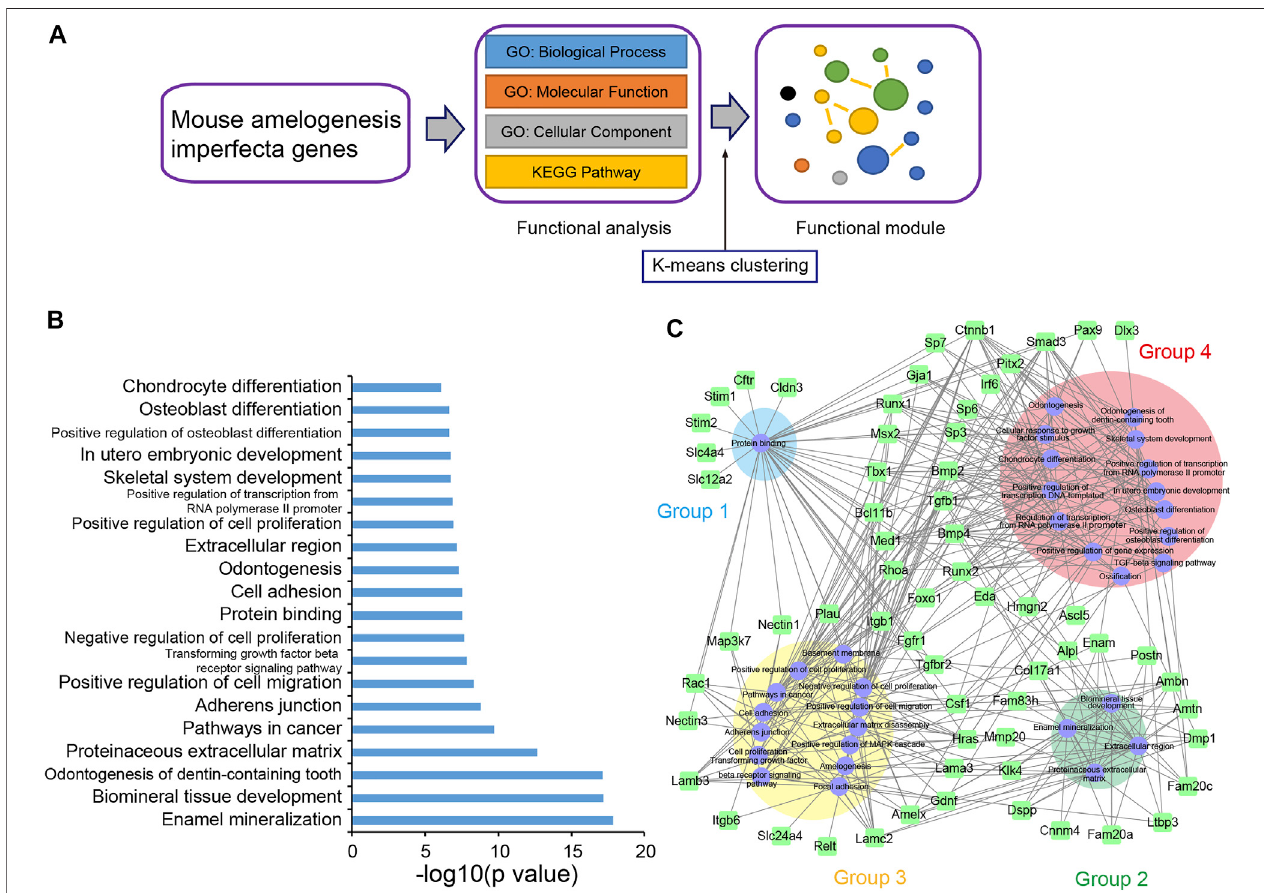
FIGURE 2 | Functional enrichment analysis of mouse amelogenesis imperfecta-related genes (mAIGenes). (A) Flowchart of the functional enrichment analysis. Signi fi cant Gene Ontology (GO) terms and KEGG pathways were determined by a false discovery rate (FDR) < 0.01. The signi fi cant gene sets were then clustered into functional modules using a k-means clustering algorithm. (B) Top 20 GO terms or KEGG pathways. Gene sets related to tooth development and cell proliferation were among the top enriched sets. (C) The gene set network showed four groups, which were ordered by the number of gene sets (the smallest number of gene sets was in Group 1). These gene sets were related to protein banding, enamel mineralization, cancer, and bone development, respectively.